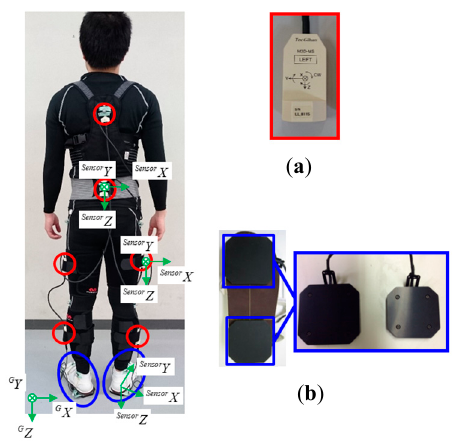
Figure 1. Mounting positions of the wearable sensor system; ( a ) Wearable motion sensor; ( b ) Wearable force